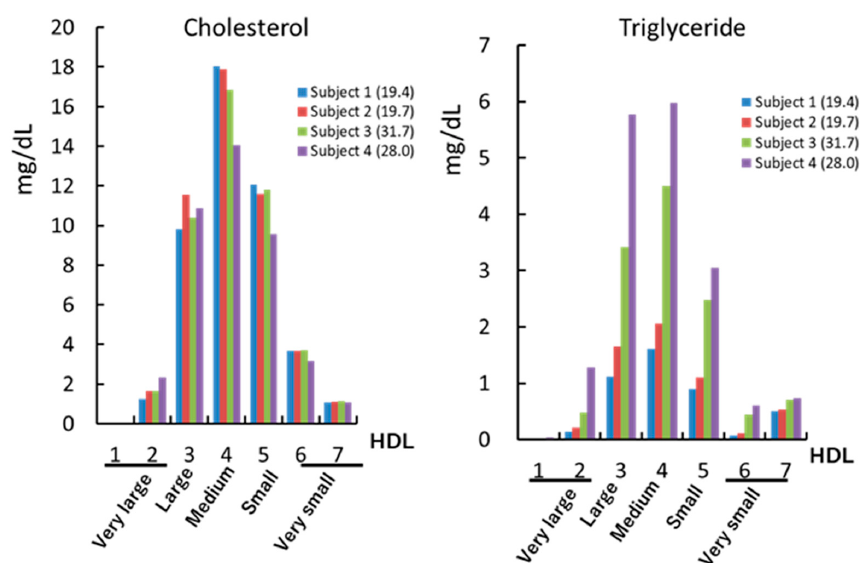
Figure 3. Concentrations of cholesterol (left panel) and triglyceride (right panel) in HDL subclasses. HDL isolated from four subjects were analyzed by using gel-permeation high-performance liquid chromatography. LOOH-HDL levels in subjects 1, 2, 3, and 4 are 19.4 mOD / min, 19.7 mOD / min, 31.7 mOD / min, and 28.0 mOD / min, respectively.